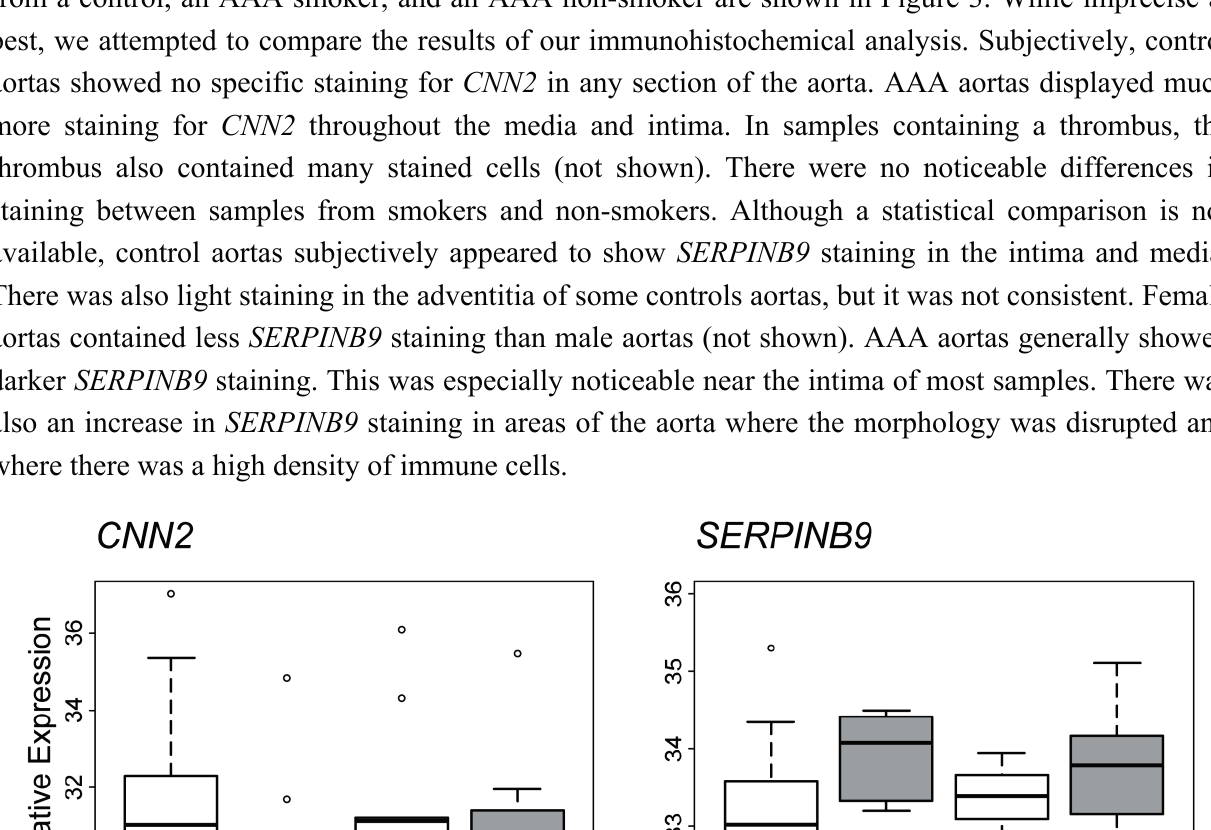
3 interquartile range units. Gene symbols available from the National Center for Biotechnology Information (NCBI; http://www.ncbi.nlm.nih.gov/) were used. See Table 1 and Supplementary Table S1 for details on the